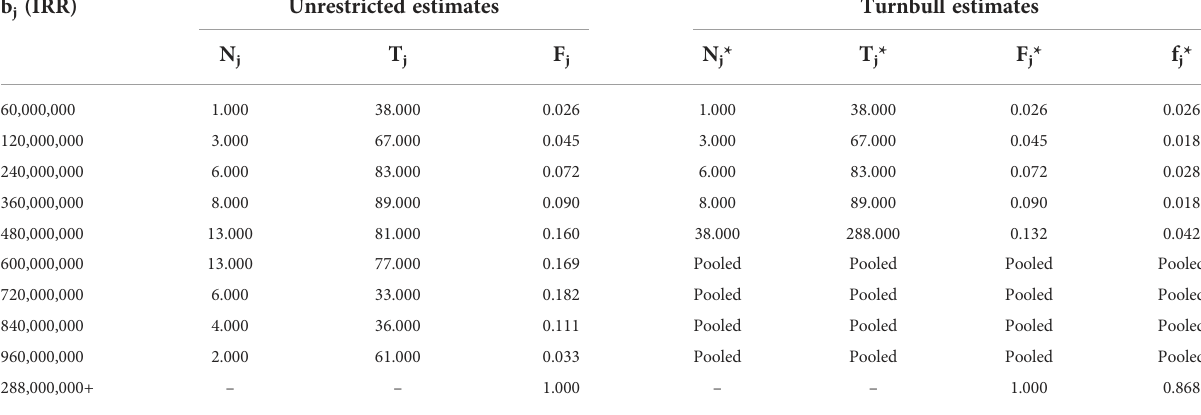
TABLE 2 Turnbull estimates with pooling for WTP per QALY (N=565). b j (IRR) Unrestricted estimates